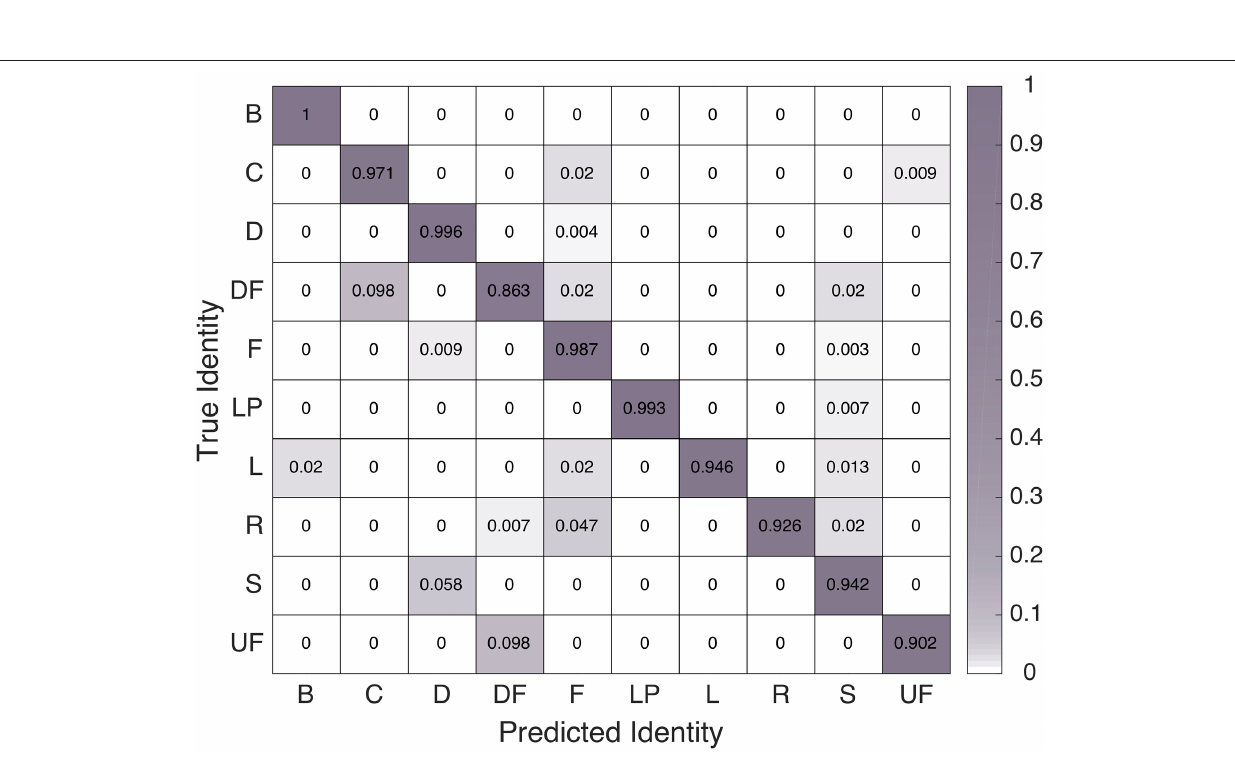
Frontiers in Robotics and AI |